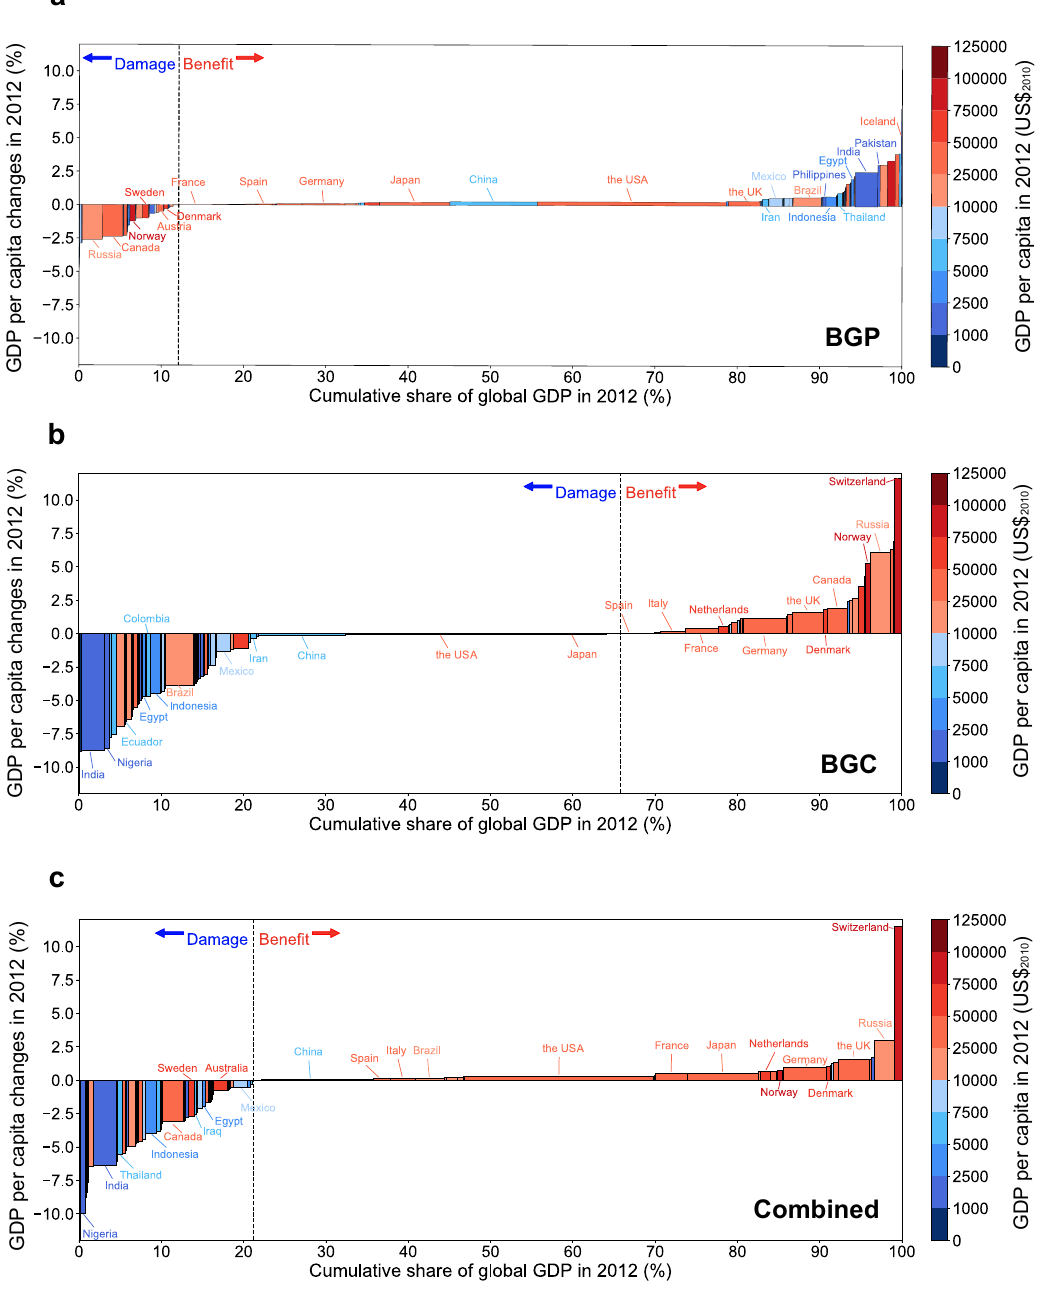
Fig. 6 The biogeophysical (BGP) and biogeochemical (BGC) impacts of historical land-use and land-cover change on economies in countries of different economic conditions via annual-mean surface air temperature (SAT) changes.